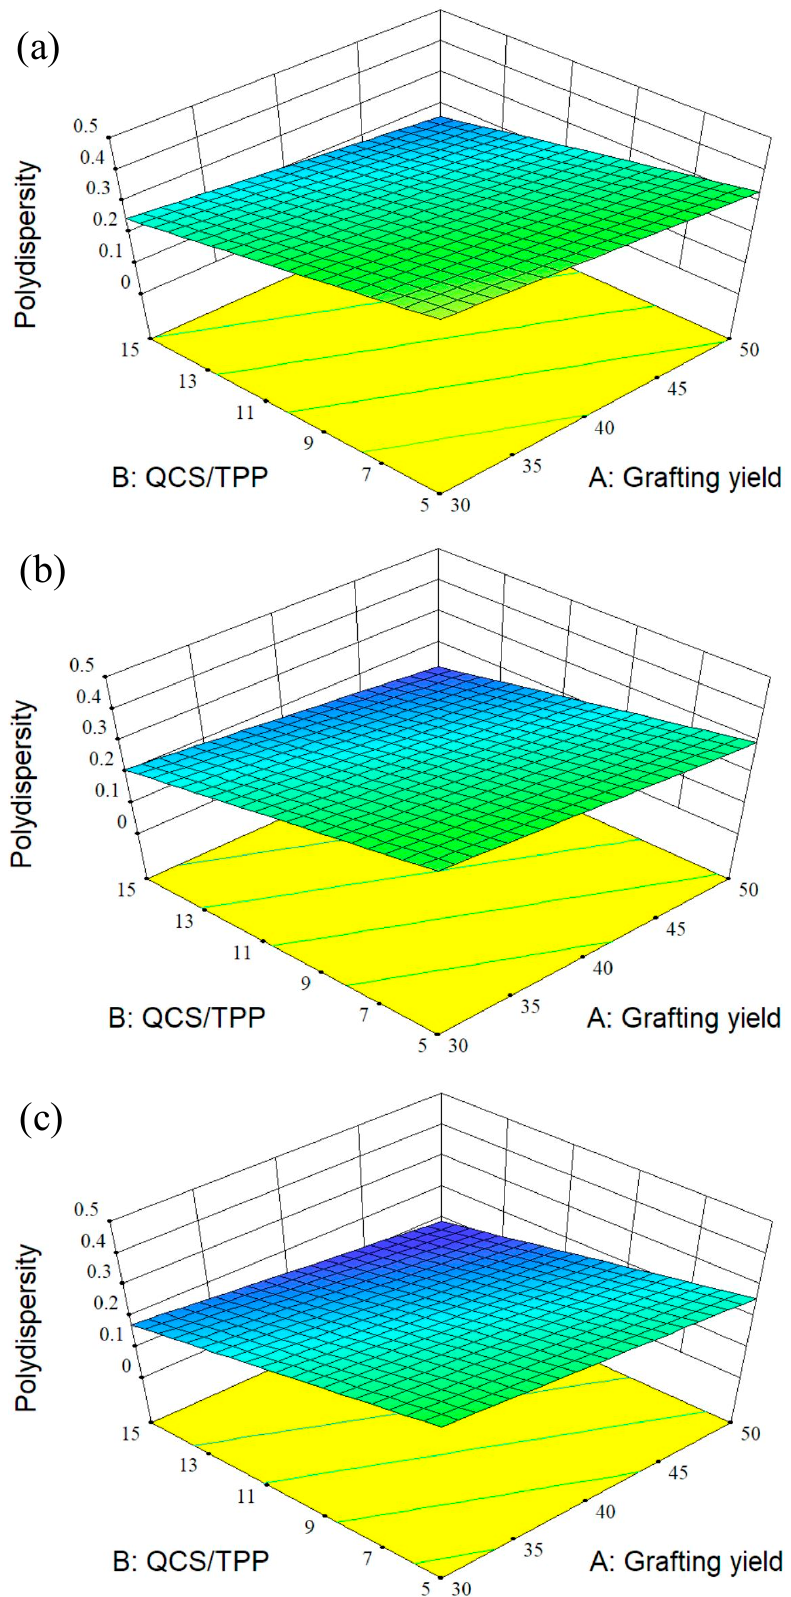
Figure 5. 3D response surface plots showing the effects of grafting yield and weight ratio of QCS/TPP at different weight ratios of QCS/genipin of ( a ) 20/1, ( b ) 40/1, and ( c ) 60/1 on PDI.